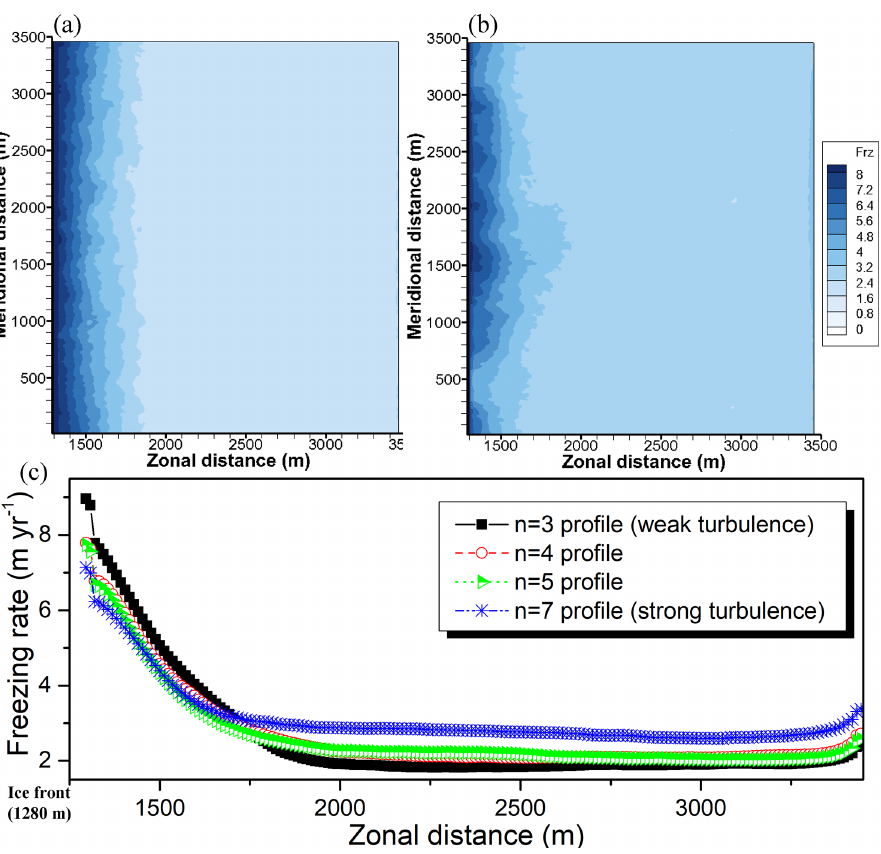
Figure 4. XY horizontal distribution of the 3 t ∗ time-averaged freezing rate (myr − 1 ) at the sea surface. (a) Freezing rate in the case of n = 3, weak turbulence. (b) Freezing rate in the case of n = 7, strong turbulence. (c) Zonal–spatial distribution of the freezing rate in the four different turbulence cases. These values are averaged along the meridional